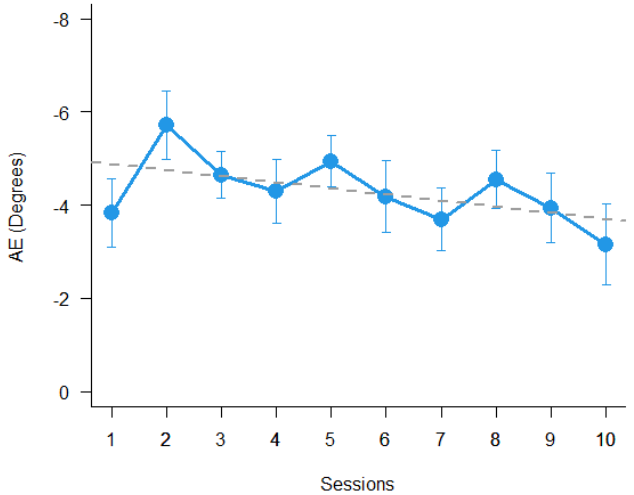
Figure 3. Mean aftereffect of PA over sessions for spatial neglect patients. Bars represent ± 1 SEM. The baseline comparison between groups on each neuropsychological test, in the 1st session, at T1, did not reach the appropriate level of significance. The results for the first sessions (T1) are shown in Figure